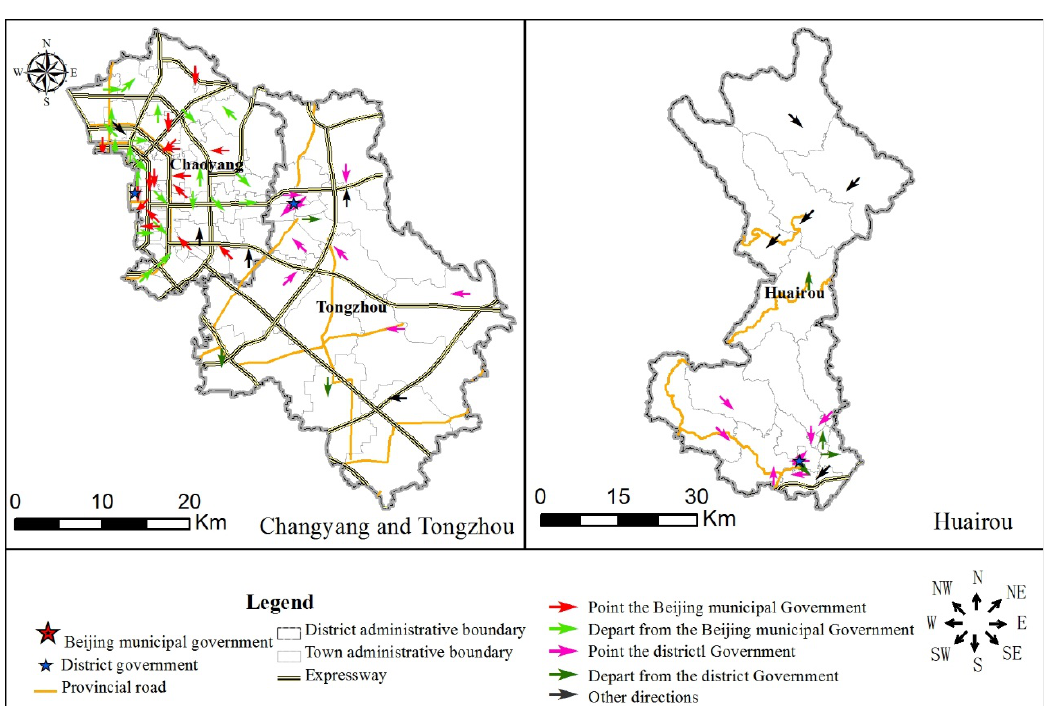
Figure 13. Urban land expansion directions at town level.